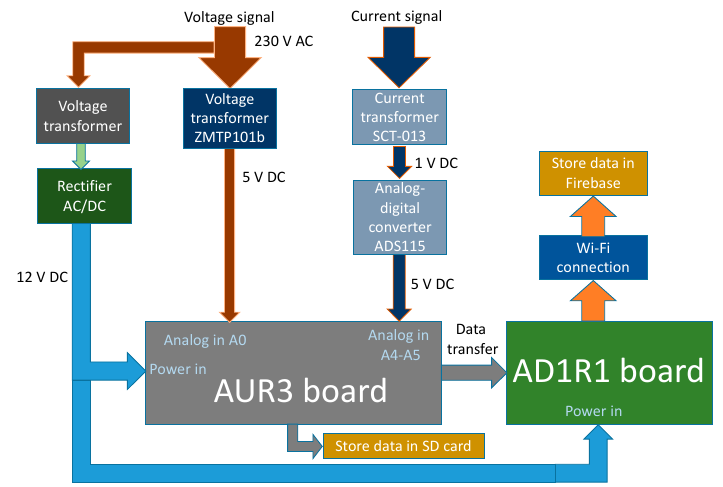
Figure 2. Hardware block diagram of the OSPPSM.